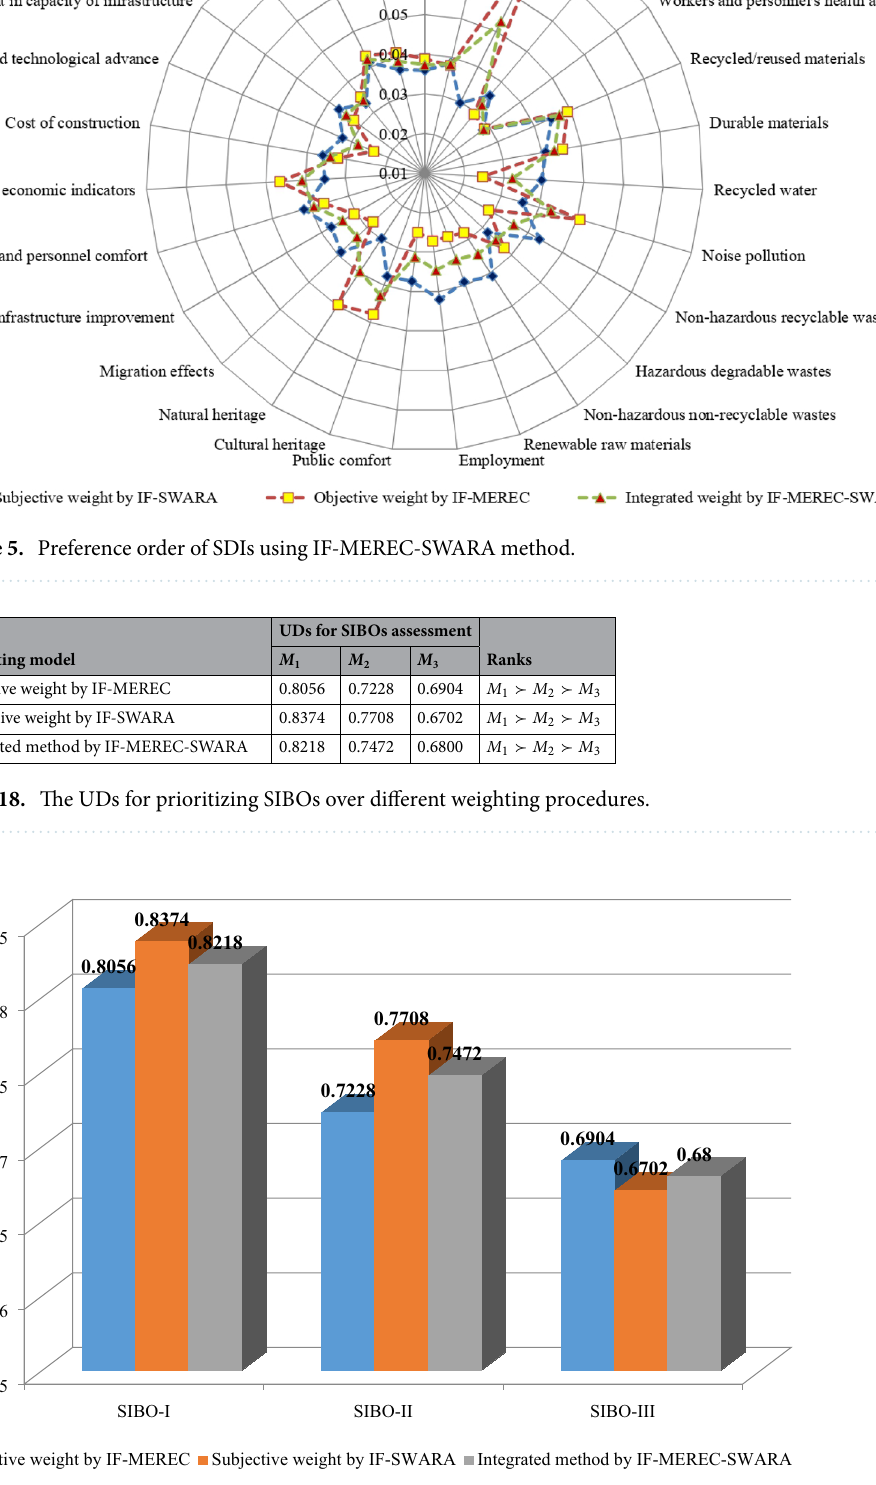
Figure 6. Sensitivity analysis for prioritizing SIBOs with different weighting